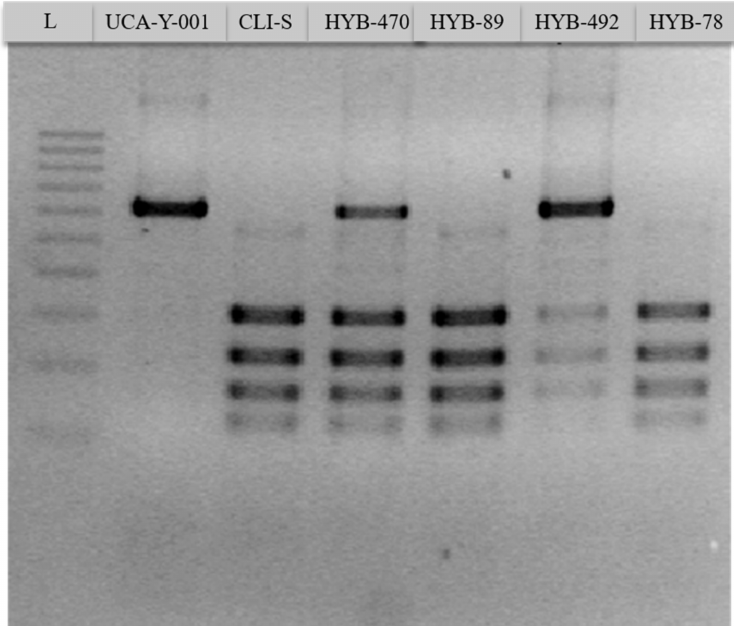
Figure 1. Transposon PCR of parental strains (UCA-Y-001, CLI-S) and some of the putative hybrids (HYB-470, HYB-89, HYB-492 and HYB-78). L: Generuler 100 bp plus.